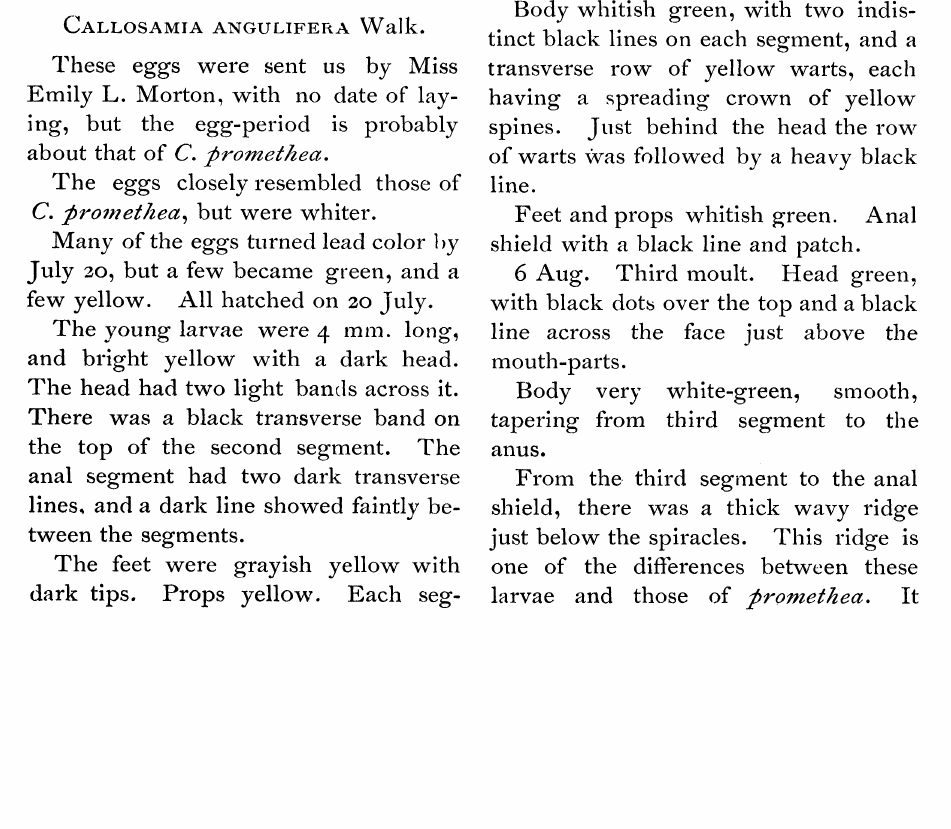
ment had six warts and spines, except the first and last which had four. 2 7 July. First moult. Head yellow with a dark line and dark patch across it. Each segment had two transverse black lines on dorsum. Body-color greenish yellow. On the first segment were. four black warts with black spines. On the eleventh segment were three warts, the middle and largest one being on the dorsal line, and two warts just behind these. On each of the other segments were six yellow warts with yellow, black-tipped spines. Anal shield with a transverse line and patch of black. Feet and props pale yellow-. 3 July. Second moult. Head pale green with dark mouth-parts. Body whitish green, with two indis- tinct black lines on each segment, and a transverse row of yellow warts, each having a spreading crown of yellow spines, just behind the head the row of warts Was followed by a heavy black line. Feet and props whitish green. Anal shield with a black line and patch. 6 Aug. Third moult. Head green, with black dots over the top and a black line across the face just above the mouth-parts. Body very white.green, smooth, tapering from third segment to the anus. From the. third segment to the anal shield, there was a thick wavy ridge just below the spiracles. This ridge is one of the differences between these Each seg- larvae and those of hrometea.